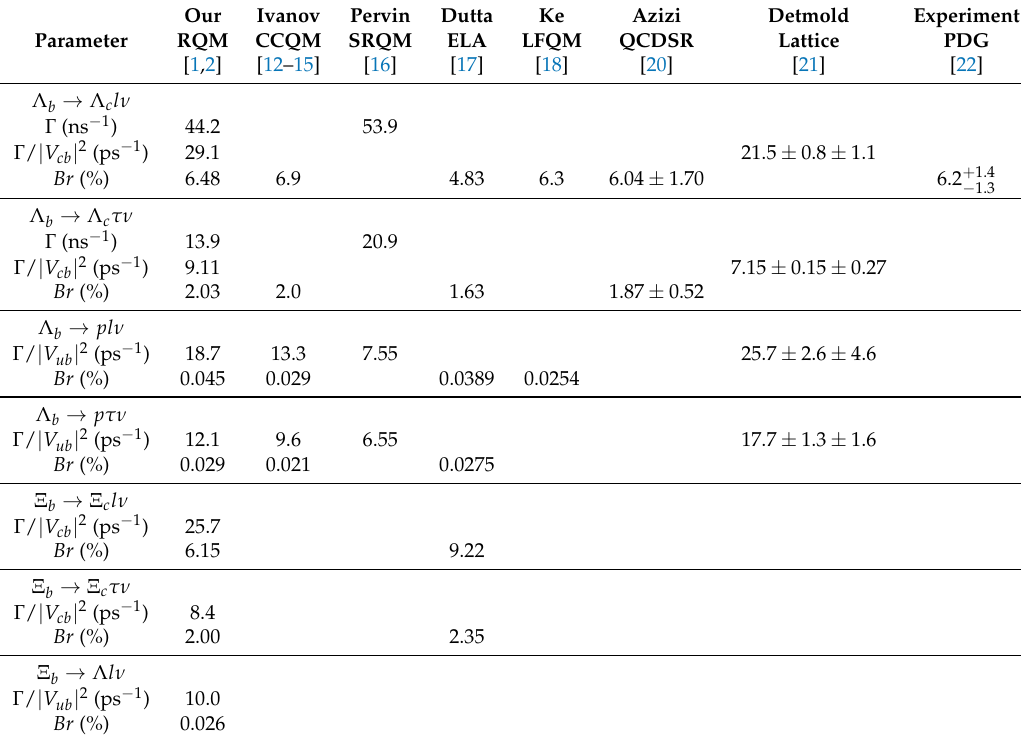
Figure 3. Predictions for the differential decay rates of the Λ b semileptonic decays. Table 1. Comparison of theoretical predictions for baryon semileptonic decays with experimental